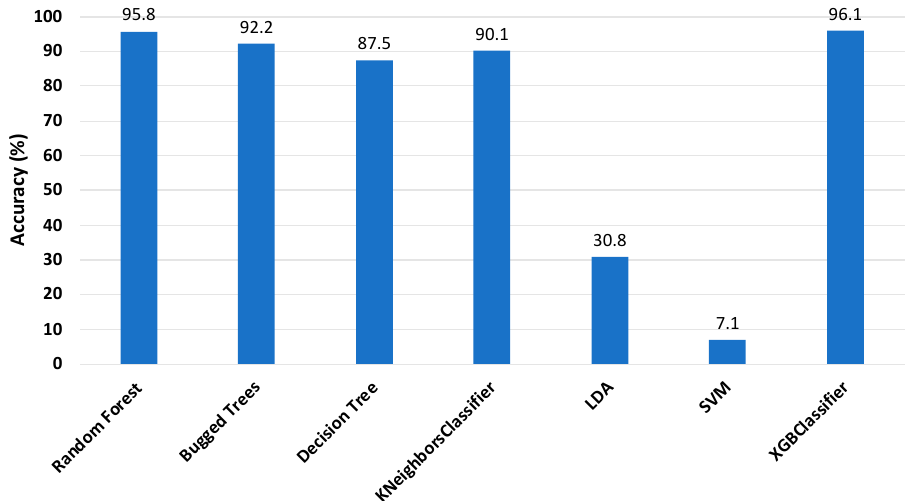
Figure 8. Accuracy of classifiers with 25 features (sensor 2).